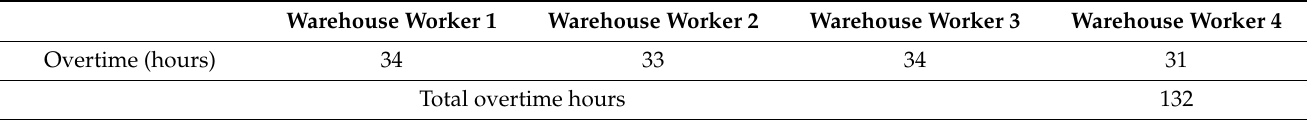
Table 3. Average overtime hours per